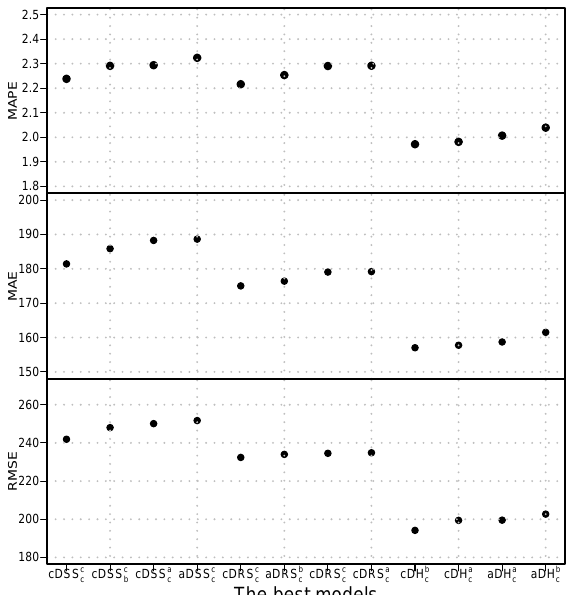
Figure 4. Performance measures: the accuracy measures for the best twelve models: MAPE ( top ), MAE ( center ), and RMSE ( bottom